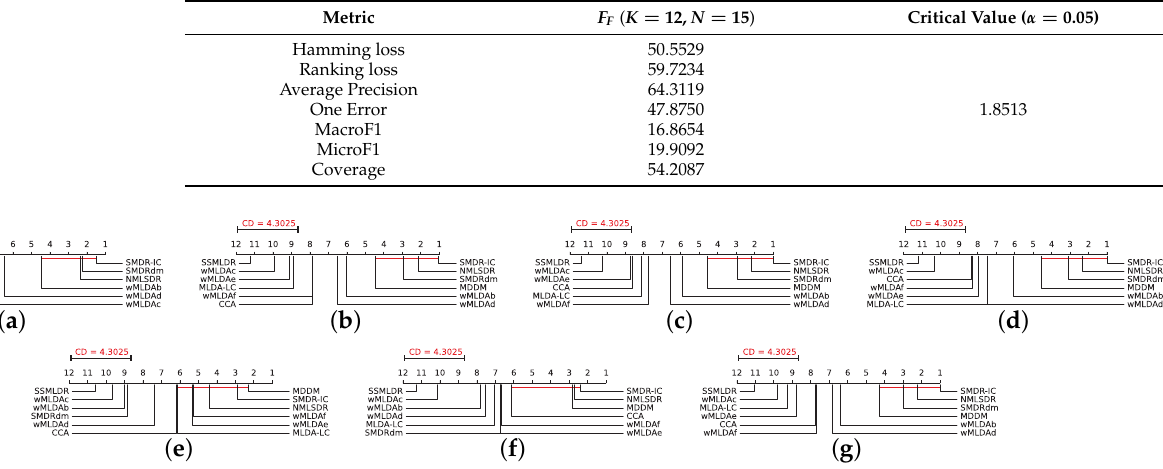
Figure 2. Bonferroni–Dunn test for SMDR-IC and other compared techniques. ( a ) 1-Hamming. ( b ) 1-Ranking. ( c ) AvgPrec. ( d ) 1-OneError. ( e ) MacroF1. ( f ) MicroF1. ( g )